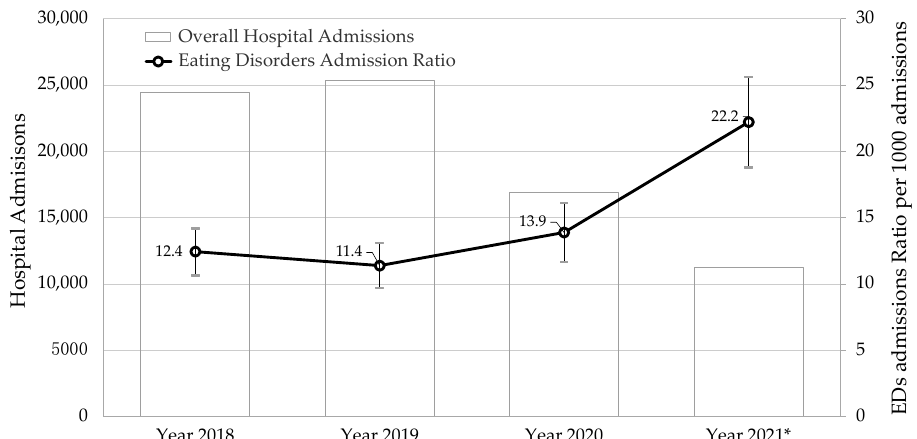
Figure 1. Overall hospital admissions and age adjusted (with 95% confidence intervals) EDs ratio of hospital admissions per 1000 admissions, pre (year 2018 and 2019), during (2020) and post (2021) pandemic peak; Piedmont region, Italy (* Year 2021 comprises data from 1 January 2021 to 30 September 2021 due to dataset information availability). Table 1. Gender age-specific and age-adjusted (with 95% CIs) EDs ratio of hospital admissions per 1000 admissions, pre (years 2018 and 2019), during (2020) and post (2021) the pandemic peak; Piedmont region,